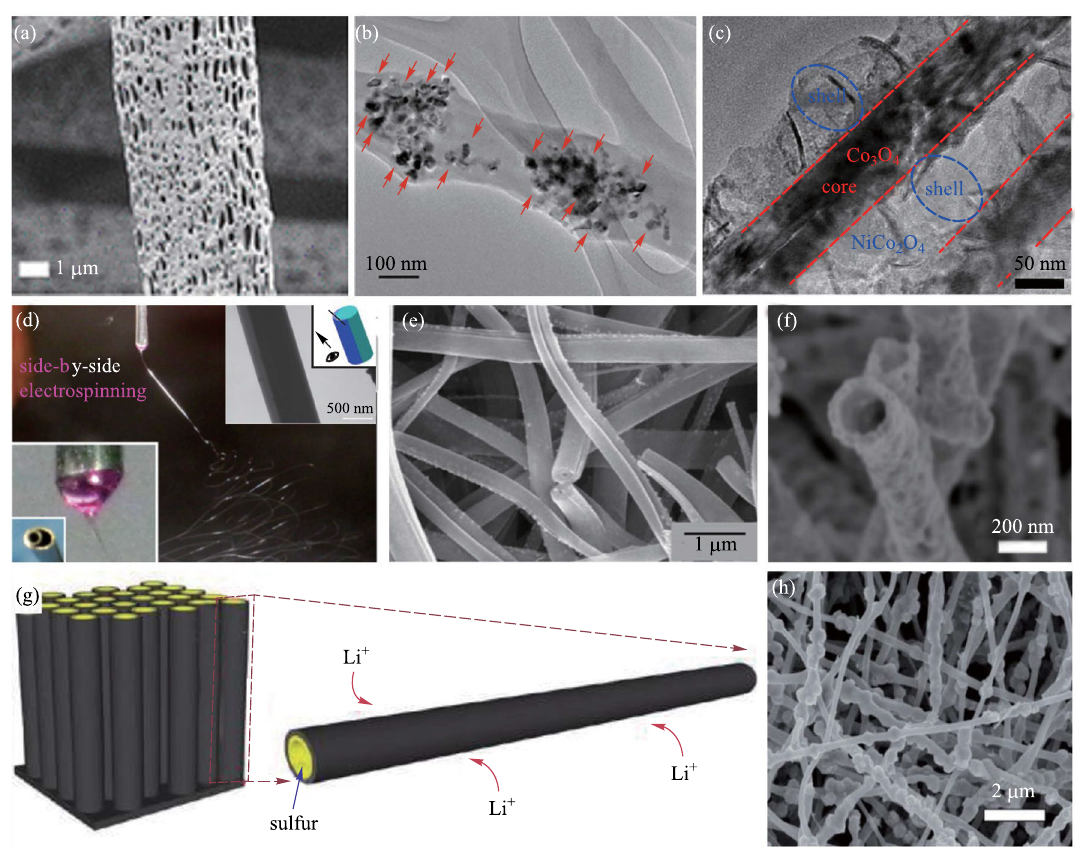
Fig. 3 Various structures of nanofibers. a SEM photo of porous nanofibers [60]. b TiO